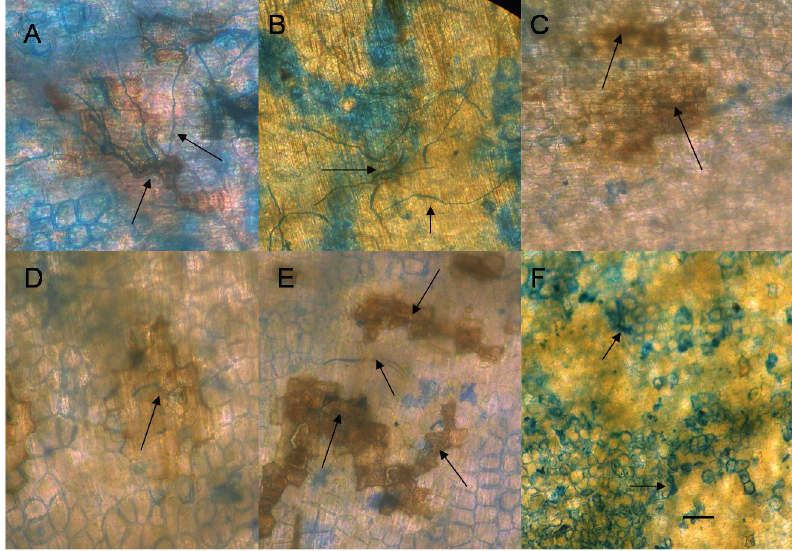
Figure 5. Low concentrations of EDTA induce resistance in pea endocarp tissue against the pea pathogen, Fusarium solani f. sp. pisi (Fspi). Twenty min of pretreatments (10 μ L) of ( A ) water and ( B ) 6 mM EDTA; ( C ) 3 mM EDTA; ( D ) 1.5 mM EDTA; ( E ) 0.7 mM; and ( F ) 0.3 mM EDTA concentrations were applied to pea tissue 20 min prior to 5 µL of a 1.3 × 10 6 spore suspension of Fspi. Photos represent the extent of growth typical from the lesion observations of 30 spores for each concentration of EDTA applied. Arrows indicate the location of the spores or mycelia distorted or suppressed by the treatments. (Note: Bar = 50